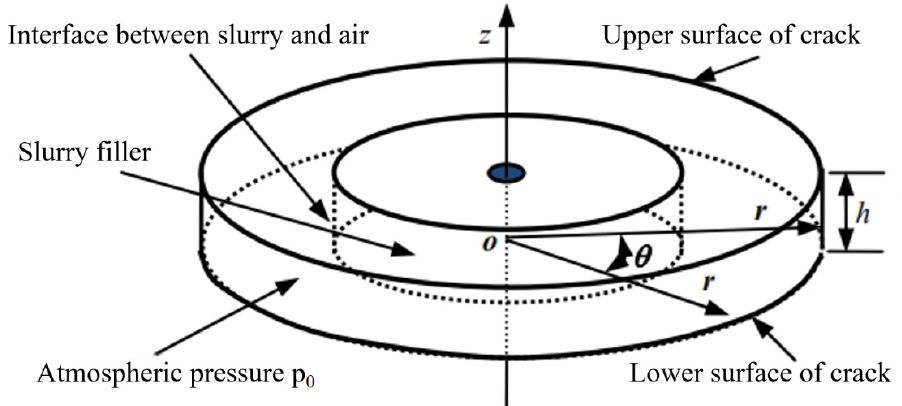
Figure 3. Schematic diagram of self-expanded slurry diffusion in flat single fracture.